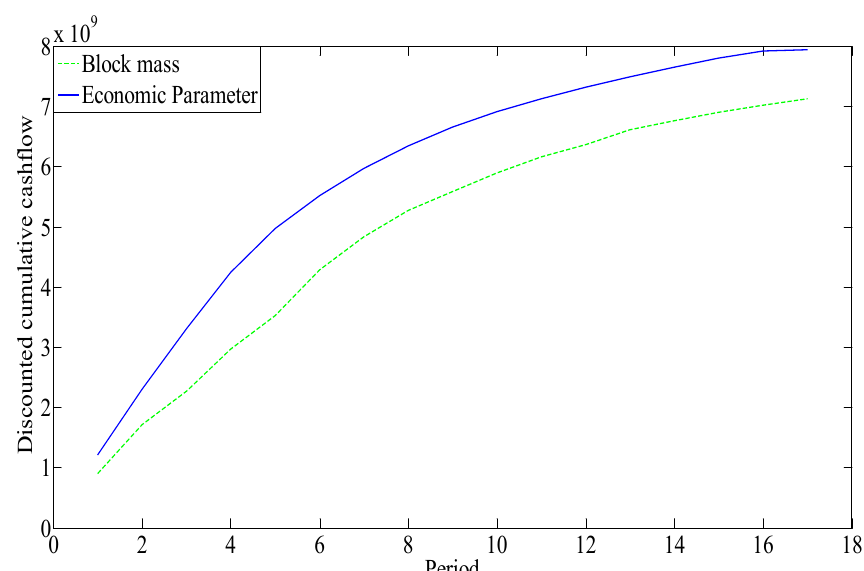
Figure 16. Discounted cash flow comparison between the existing model and proposed model (block mass represents the model existing model from Joshi et al. [19], and economic parameter represents the proposed model).